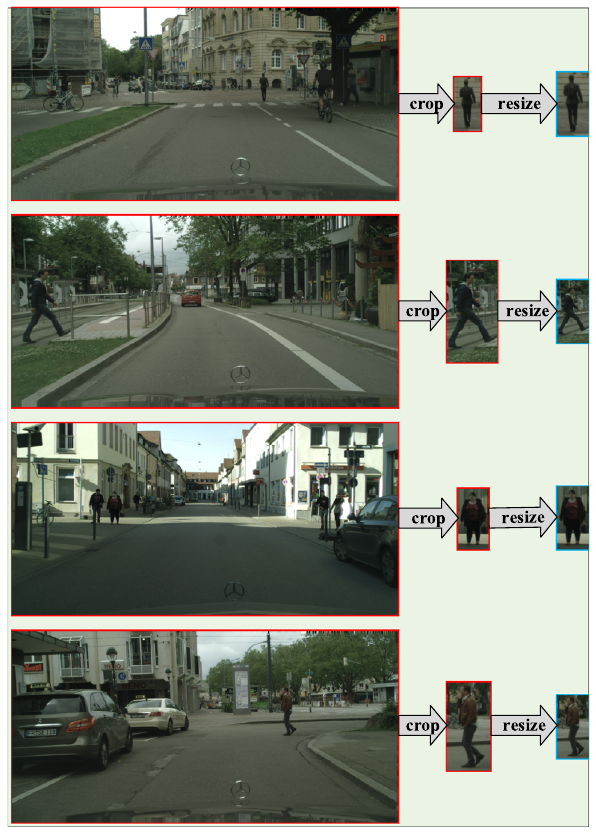
Fig. 17 Cityscapes preprocessing